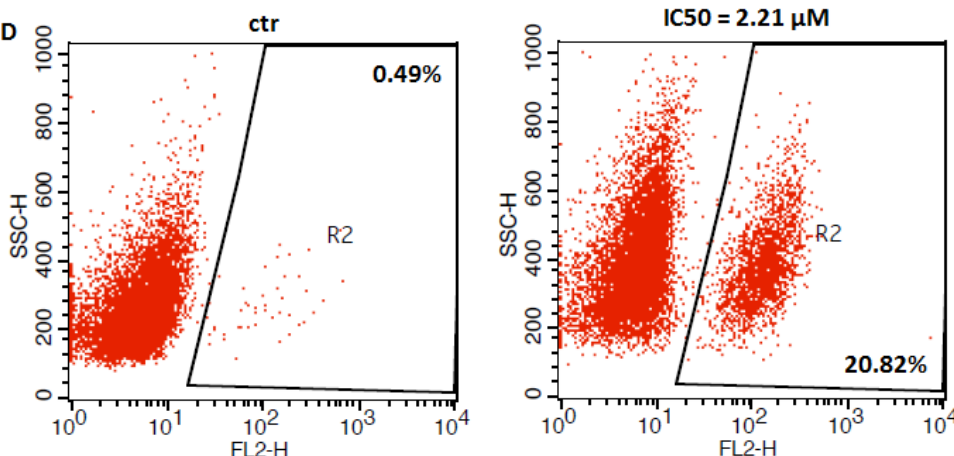
Figure 5. Representative flow cytometry dot plot graphs of A375 ( A ), FM55P ( B ), FM55M2 ( C ), and SK-MEL28 ( D ) melanoma cell lines after the treatment with a medium (ctr) and betulinic acid (BA) at their IC 50 concentrations for 72 h. Region R2 included apoptotic cells with active caspase-3. Table 1. The anti-proliferative effects of betulinic acid (BA), paclitaxel, and docetaxel administered alone in human malignant melanoma cell lines measured in vitro by the MTT assay. Data are me- dian inhibitory concentrations (IC values ± SEM). 2.4. Isobolographic Analysis of Interaction between BA and Taxanes in Melanoma Cell Lines Next, the median inhibitory concentrations (IC 50 values) were calculated from equa- tions of log-probit concentration – response relationship curves (CRRCs) for BA and Paclitaxel (Figure 6A – D) and for BA and Docetaxel (Figure 7A – D). They are summarized in Table 1. We observed that BA, Paclitaxel, and Docetaxel showed an antiproliferative effect on the melanoma cells, with IC 50 values ranging from 2.21 ± 0.42 to 15.94 ± 3.95 µM, from 4.63 ± 0.62 to 96.20 ± 14.61 µM, and from 1.27 ± 0.55 to 15.83 ± 9.05 µM, respectively. The test for parallelism between BA and Paclitaxel revealed that the lines of both compounds were non-parallel to each other in the A375, SK-MEL28, and FM55M2 cell lines and parallel to one another in the FM55P (Figure 6). In turn, the test for parallelism between BA and Docetaxel revealed that the lines of both compounds were parallel to each other only in the A375 cell line (Figure 7).